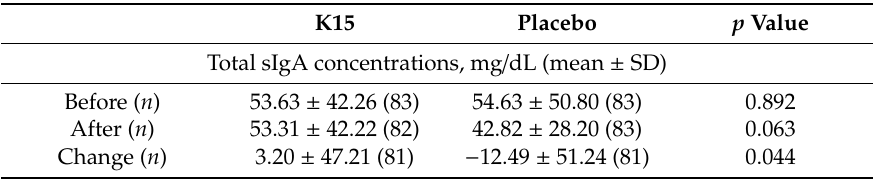
Table 5. sIgA concentrations in